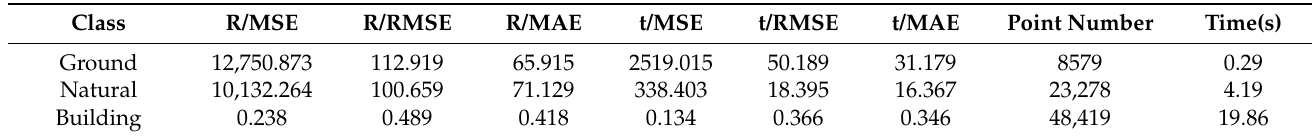
Table 4. Registration error and time for different classes.